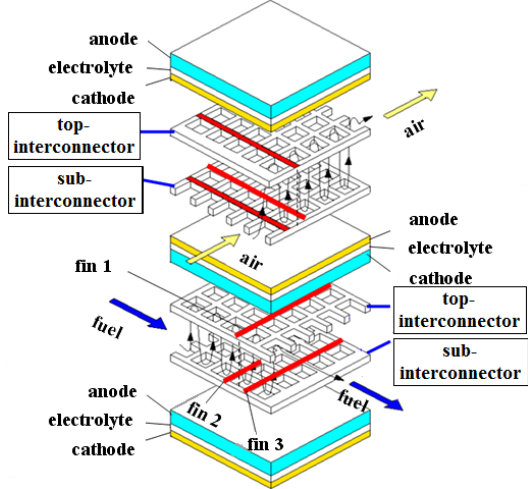
Figure 1. Schematic plot of bi-layer interconnector solid oxide fuel cell (SOFC) in the references [21,22]. Reprinted/Reproduced with permission from [21]. Copyright 2011 Elsevier.